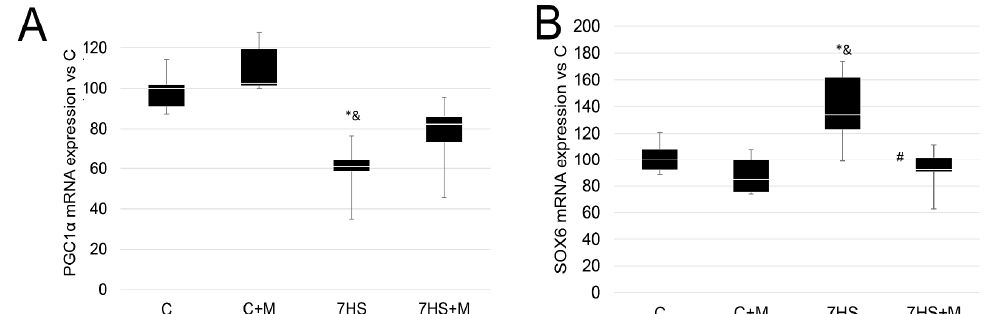
Figure 5. RT-PCR analysis of PGC1alpha mRNA expression ( A ) and SOX6 mRNA expression ( B ) in the control group (C), control group with metformin (C+M), 7-day hindlimb-suspended group (7HS), and 7-day hindlimb-suspended group with metformin (7HS+M). Data are shown as % of the control group and median of the C group has been arbitrarily set to 100%. *—significant difference from the control group. &—significant difference from C+M group. #—significant difference from 7HS group ( p < 0.05). Box plots show 25–75 percentiles and median values and the whiskers represent the minimum and the maximum; n = 8/group.